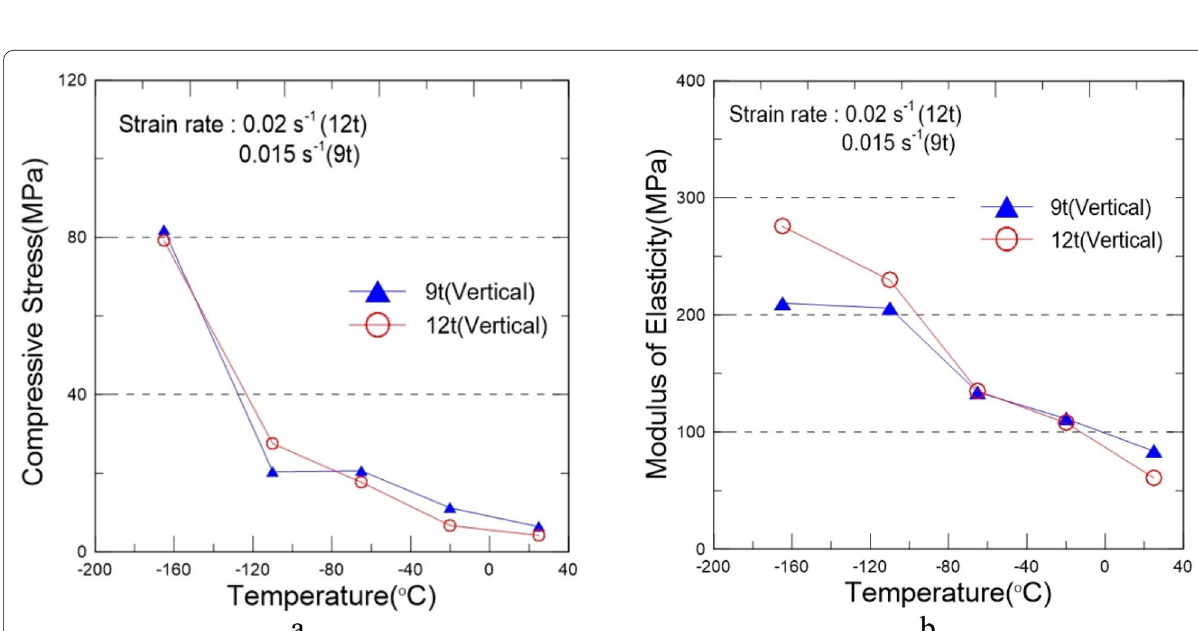
Fig. 15 a Average compressive strength and b average modulus of elasticity of plywood in the vertical